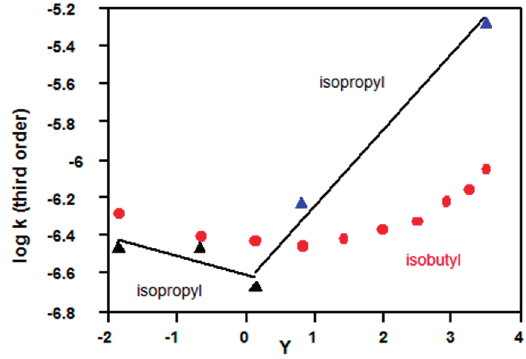
Figure 7. Changes in mechanism based on plots of log k 3 vs. Y Equation (3) for solvolyses in acetone-water of 5 , R = i Pr at 40 °C and 5 , R = CH 2 CH(CH 3 ) 2 at 45 °C; kinetic